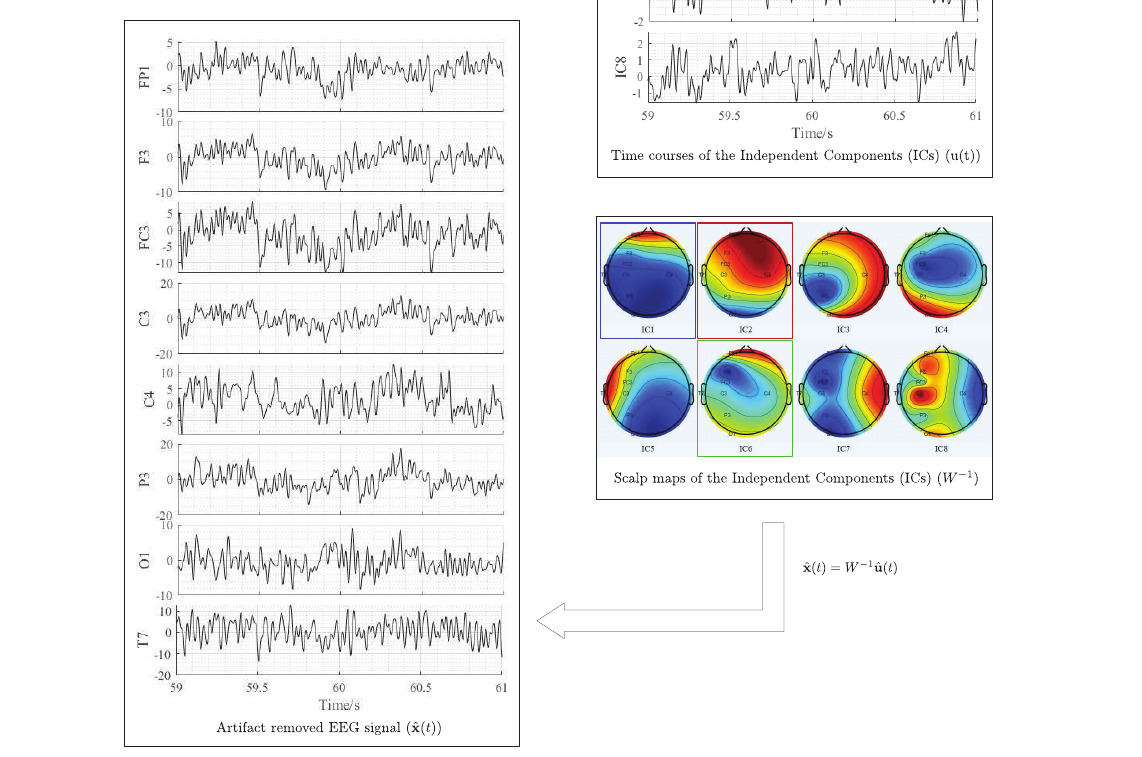
Frontiers in Neurorobotics |